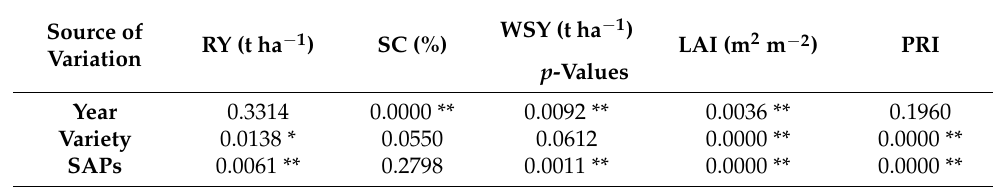
Table 1. Analysis of variance (ANOVA) for impact of different source of variation on production pa- rameters: root yield (RY), sugar content (SC), white sugar yield (WSY) and physiological parameters: leaf area index (LAI), photochemical reflectance index